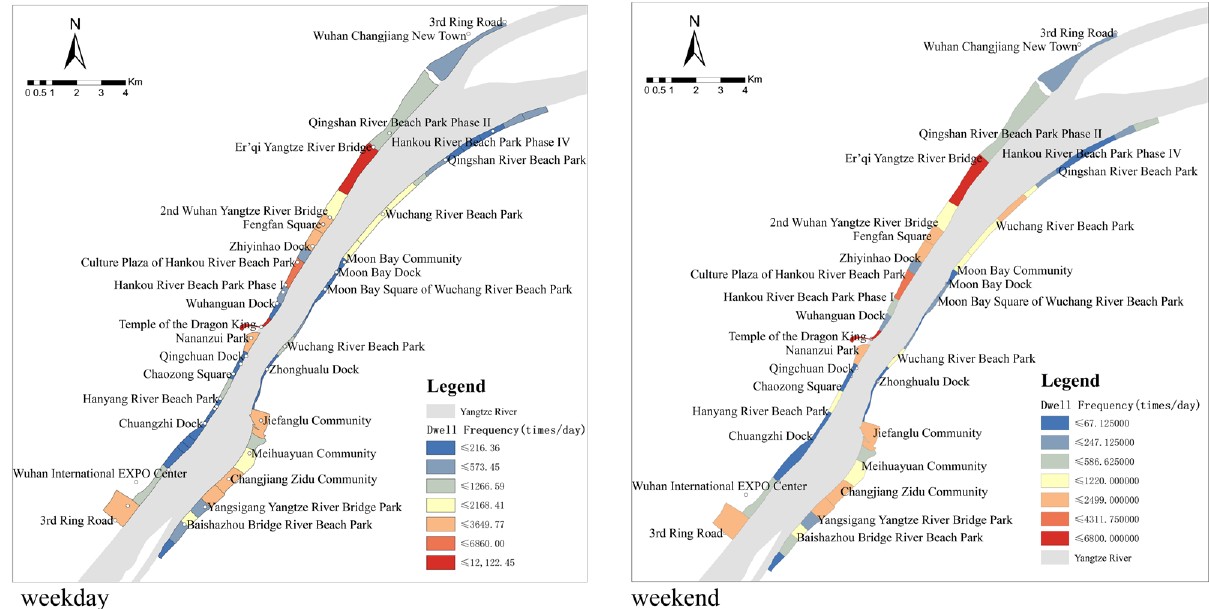
Figure 8. The dwell frequency distribution of the riverside area of Wuhan.